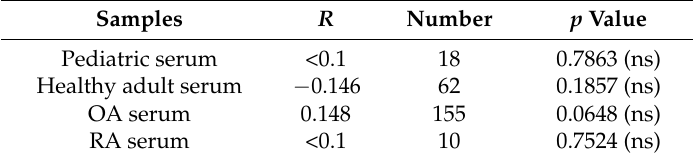
Table 3. Correlation (r) between hsPRO-C2 and PIIANP serum levels in randomly selected pediatric, healthy adults, OA, and RA samples. Results are Pearson’s correlation coefficients, adjusted for age, body mass index and gender. ns = non-significant